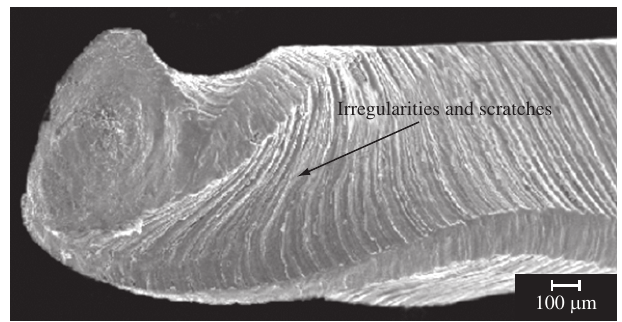
Figure 5. Representative morphology of an endodontic file (ProFile #15) after mechanical testing, showing the reversion in the direction of the helix. (SEM original magnification - 200 x ).